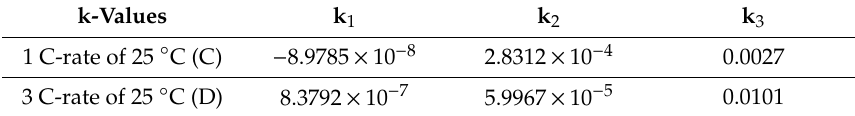
Table 8. The k-values of 1 and 3 C-rate respectively at 25 ◦ C. Negative value of k 1 is set to zero.